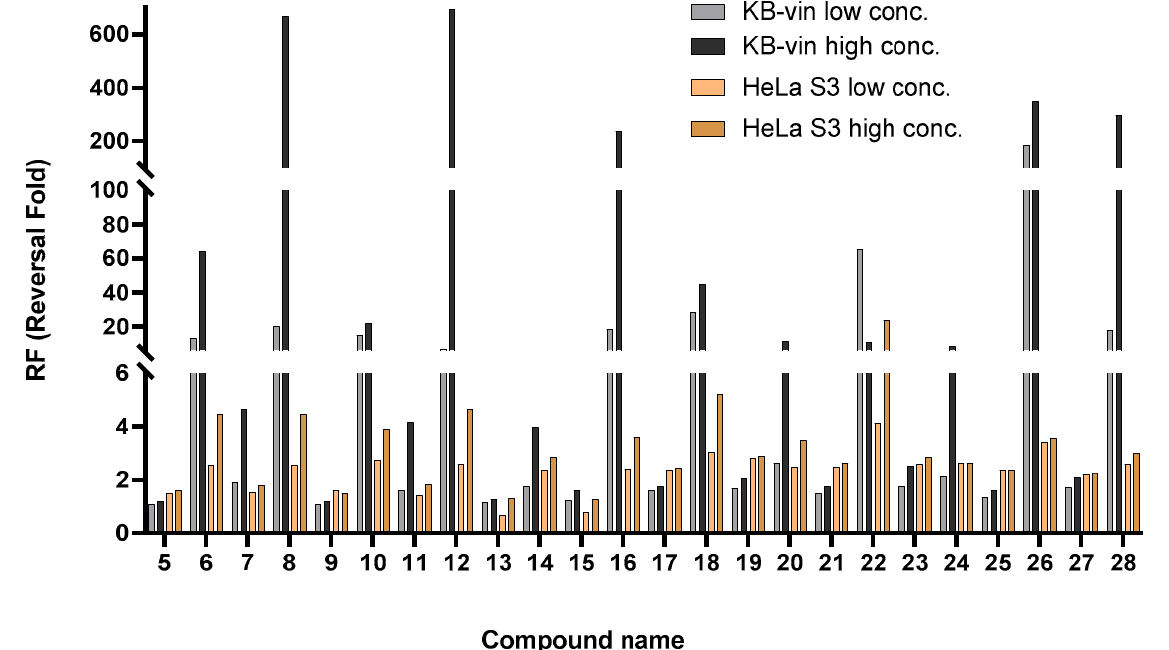
Figure 3. Reversal fold values of zhankuic acid type compounds and their methyl esters in KBvin and HeLa S3 cells. For R 5 acid-substituted compounds (odd compound number), the low concentration (conc.) was 10 µ M, and the high conc. was 20 µ M. For the R 5 ester-substituted compounds (even compound number), the low conc. was 5 µ M, and the high conc. was 10 µ M.